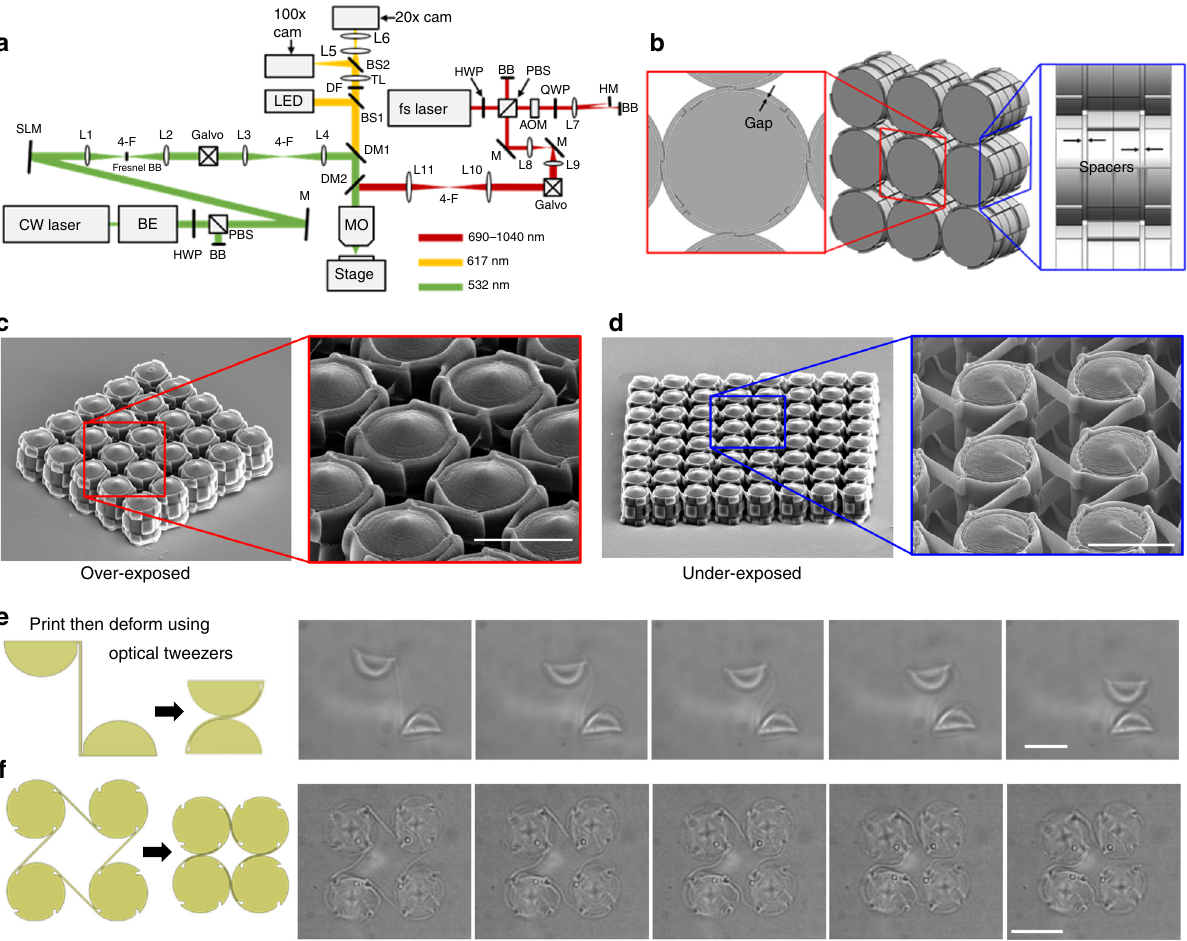
Fig. 8 Approach that enables the microfabrication of compliant rolling-contact architected materials (CRAMs). a Our system can be used to directly print CRAM lattices with already curled straps as long as b gaps and spacers exist in the design. Such lattices fail to function, however, when they are slightly c over-exposed or d under-exposed. Our system can also use scanning holographic optical tweezers to deform the fl exure straps after they have been printed straight to fabricate e compliant rolling-contact joints (CRJs) and f CRAMs with stored strain energy so they can achieve their intended properties (scale bar in c and d 10 μ m, e 20 μ m, f 30 μ